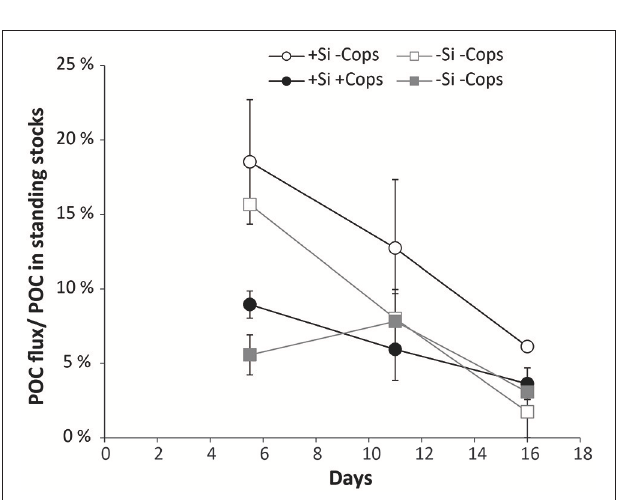
FIGURE 10 | Export efficiency: proportion of the POC produced in the surface layer, collected in the sediment traps versus time for the four treatments + Si − Cops, + Si + Cops, − Si − Cops and − Si −